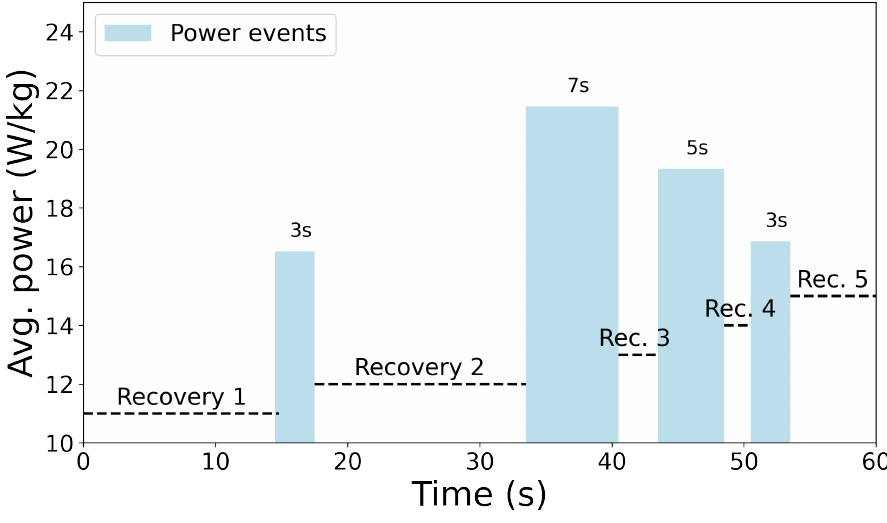
Figure 3. Recovery time within the power events (blue) in a 60 s time